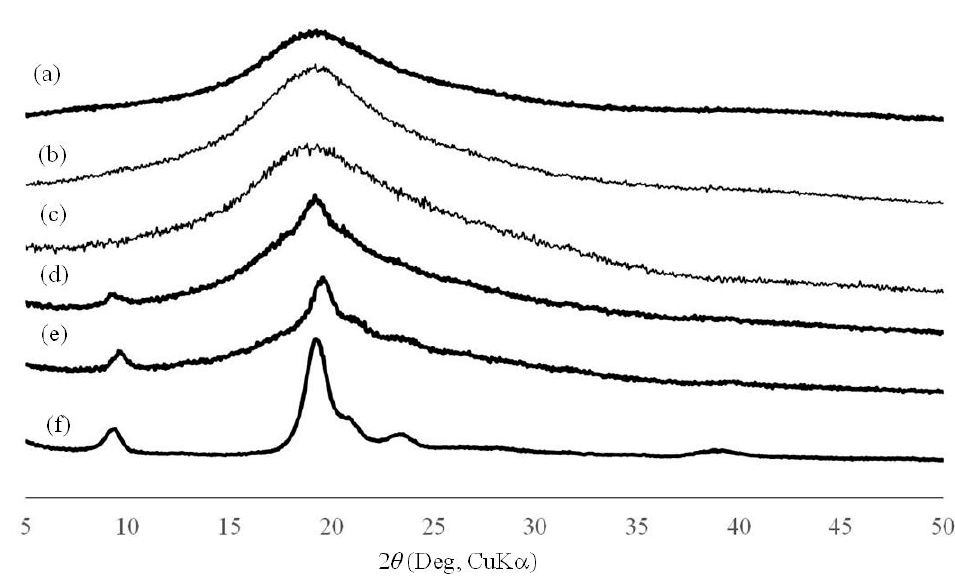
Figure 5. X-ray diffraction (XRD) profiles of ( a ) NR; ( b – e ) self-assembled CNF-NR composite sheets (CNF:NR (weight ratio) = 0.01, 0.02, 0.1, 0.2:1, respectively); and ( f ) self-assembled CNF film.